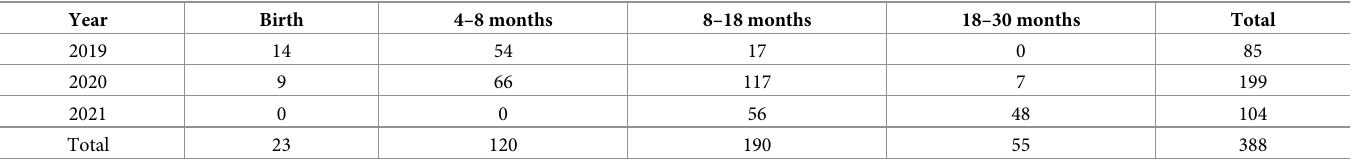
1 Infants were enrolled to be sampled at birth, 4 months, 12 months and 24 months, however sampling variation occurred due to local political, climatic, and geological events in Haiti over the course of the